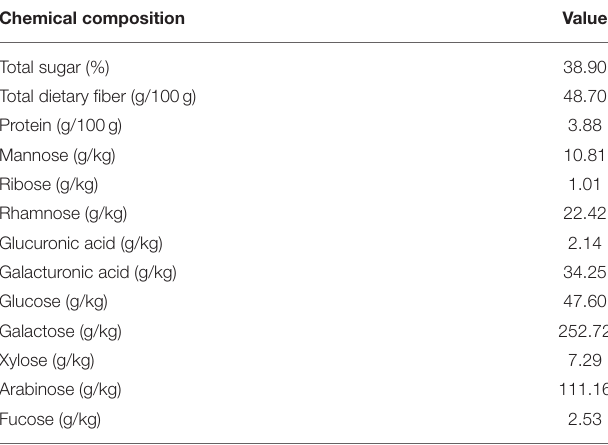
TABLE 1 | Chemical and monosaccharides compositions of